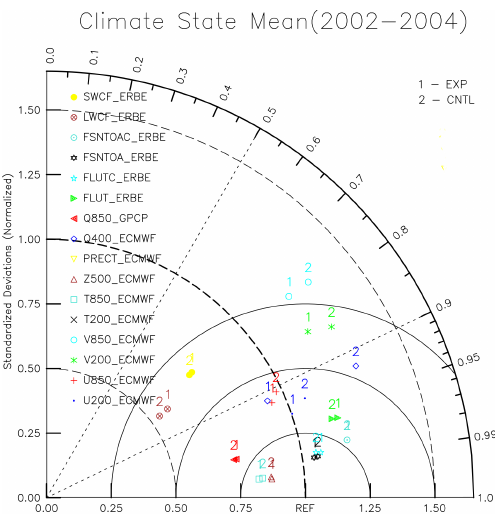
Figure 5. Improvement indices over the global, tropical and mid– high latitudes of the Northern and Southern Hemisphere (MLN and MLS) for each variable of the EXP